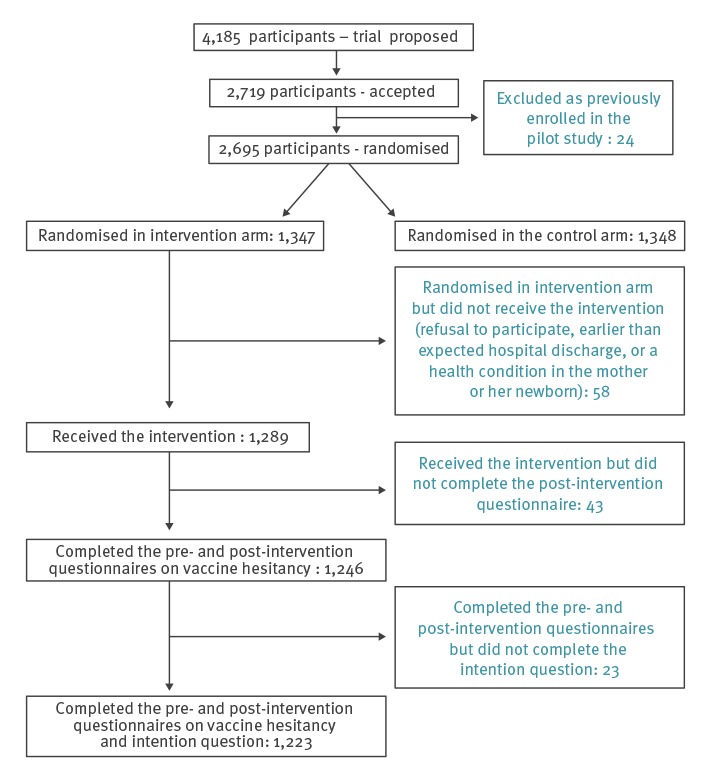
Study flowchart showing the number of participants receiving the intervention, number that completed the pre- and post-intervention questionnaires, Quebec, March 2014–February 2015 (n = 1,223)